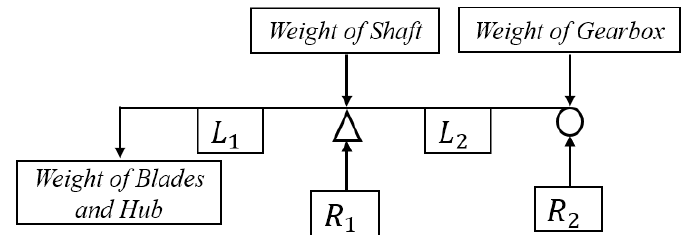
Figure 8. Reaction force calculations